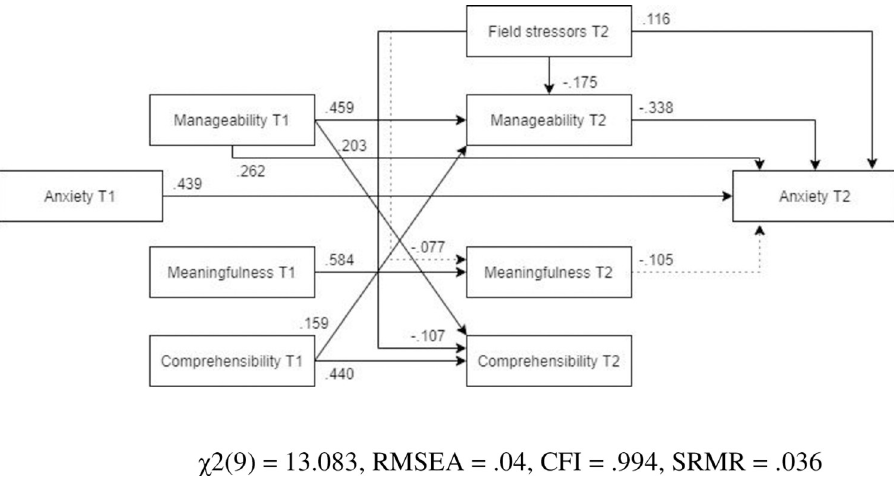
Fig 5. Tested structural equation model for anxiety—females. χ 2(9) = 13.083, RMSEA = .04, CFI = .994, SRMR =